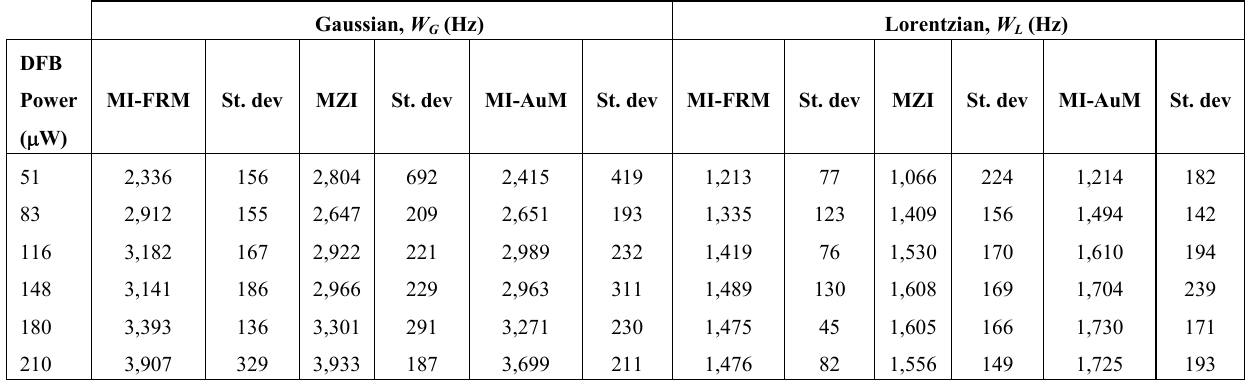
Table 1. Extracted linewidths and standard deviations of measured linewidths for MI_FRM, MZI and